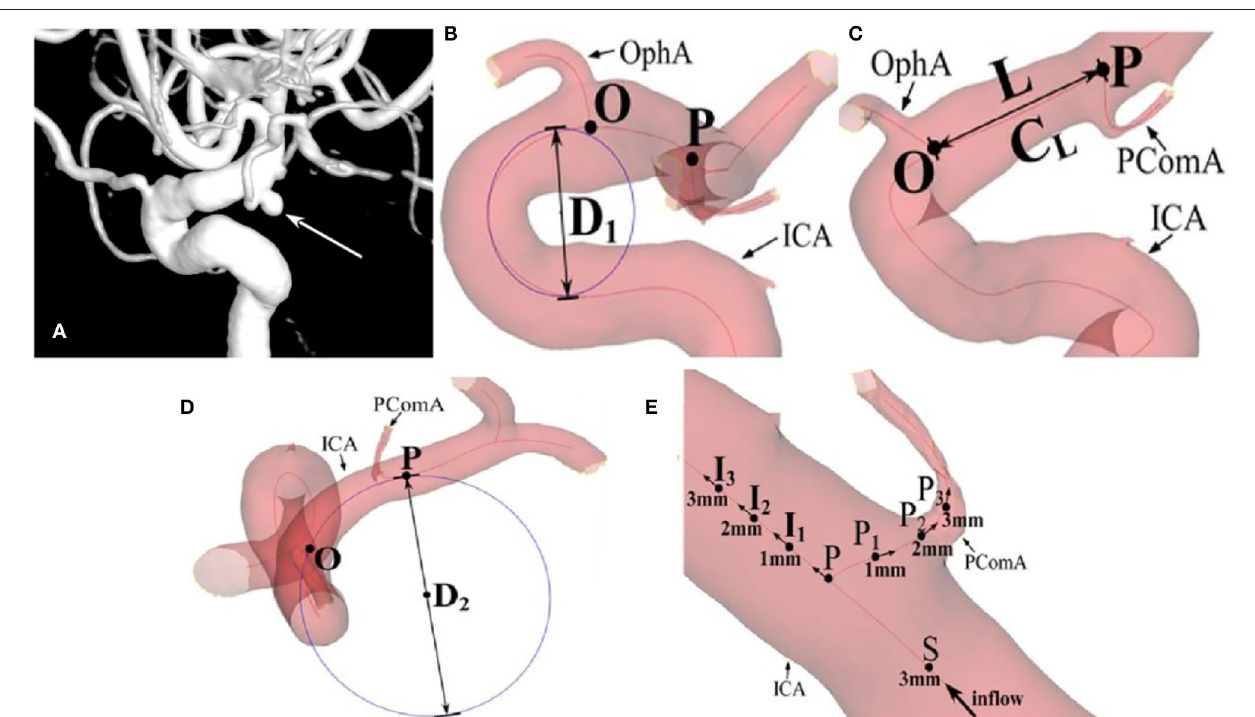
FIGURE 1 | The measurement of morphological parameters. (A) A posterior communicating artery (PComA) aneurysm is shown (arrow). (B) D 1 is the diameter of the incircle fitting the carotid siphon bend. (C) L is the length of the ICA segment from OphA bifurcation (Point O) to PComA bifurcation (Point P), and T L referred to its tortuosity. (D) D 2 refers to the diameter of the osculating circle fitting L. (E) θ is defined as the bifurcation angle between the internal carotid artery (ICA) and PComA, formed by Points I 1 , P, and P 1 . T ICA is defined as the average tortuosity of segments SI 2 and SI 3 along ICA, and the T PComA is the average tortuosity of three segments SP 2 and SP 3 along the blood flow. θ ICA refers to the average flow direction changes of PI 2 and PI 3 , and θ PComA refers to the average flow direction changes of PP 2 and PP 3 .